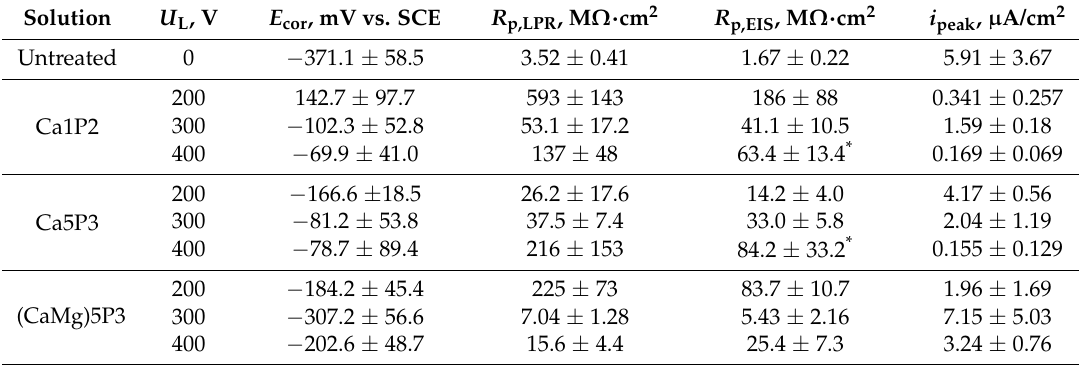
Table 3. Corrosion parameters acquired from the electrochemical